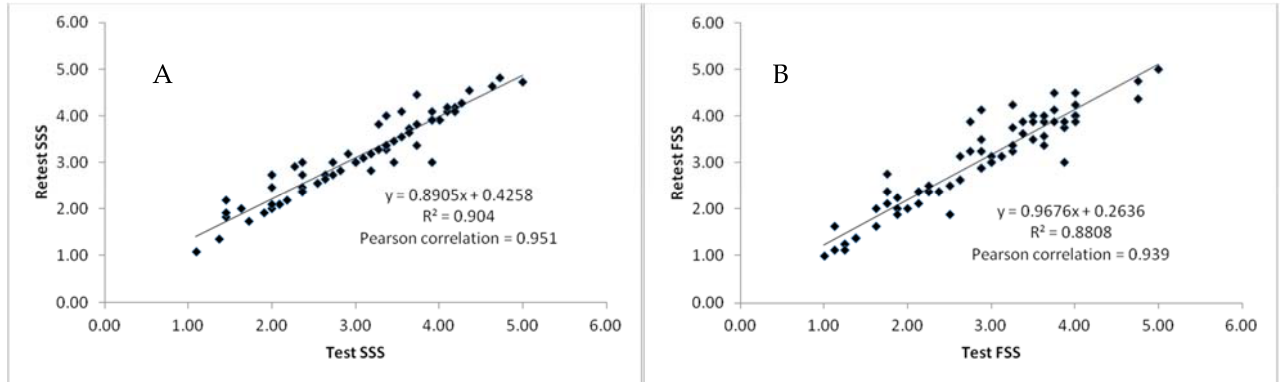
Figure 1. Scatterplot of the test and retest of the symptom severity subscale (SSS) and functional status subscale (FSS) of the Boston Carpal Tunnel Questionnaire Serbian Version (BCTQ SR ). ( A ): Scatterplot and Pearson’s correlation of the test and retest of the SSS. ( B ): Scatterplot and Pearson’s correlation of the test and retest of the FSS.